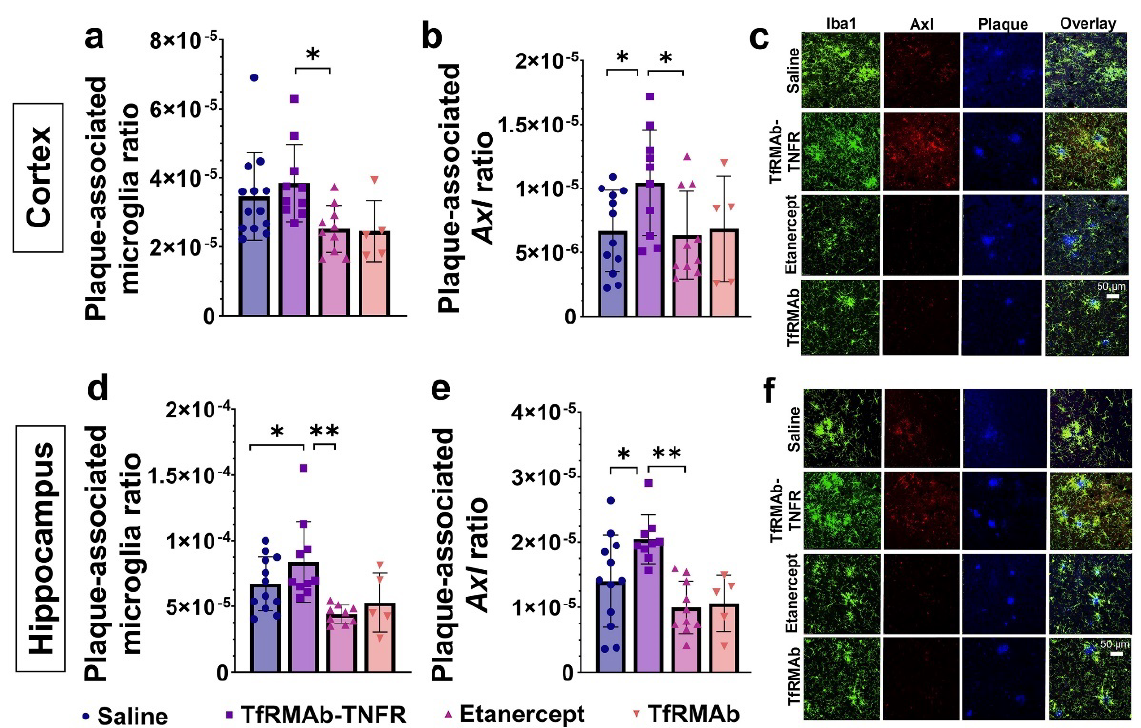
Figure 6. Effect of TfRMAb-TNFR on plaque-associated phagocytic microglia. Cortical plaque-associated microglia ( a ) and plaque-associated Axl-positive phagocytic microglia ( b ) were significantly higher in the TfRMAb-TNFR-treated mice compared with the etanercept-treated mice. Similarly, hippocampal plaque-associated microglia ( d ) and plaque-associated Axl-positive phagocytic microglia ( e ) were significantly higher in the TfRMAb-TNFR-treated mice than in the saline- and etanercept-treated mice. Representative 40 × confocal images showing Iba1 (green), Axl (red), and autofluorescent mature A β plaques (blue) in the cortex ( c ) and hippocampus ( f ). Scale bar = 50 µ m. Data are presented as mean ± SD of n = 5–13 per treatment group, and data were analyzed using the one-way ANOVA with the Holm Sidak’s post hoc test. * p < 0.05, ** p < 0.01 for the